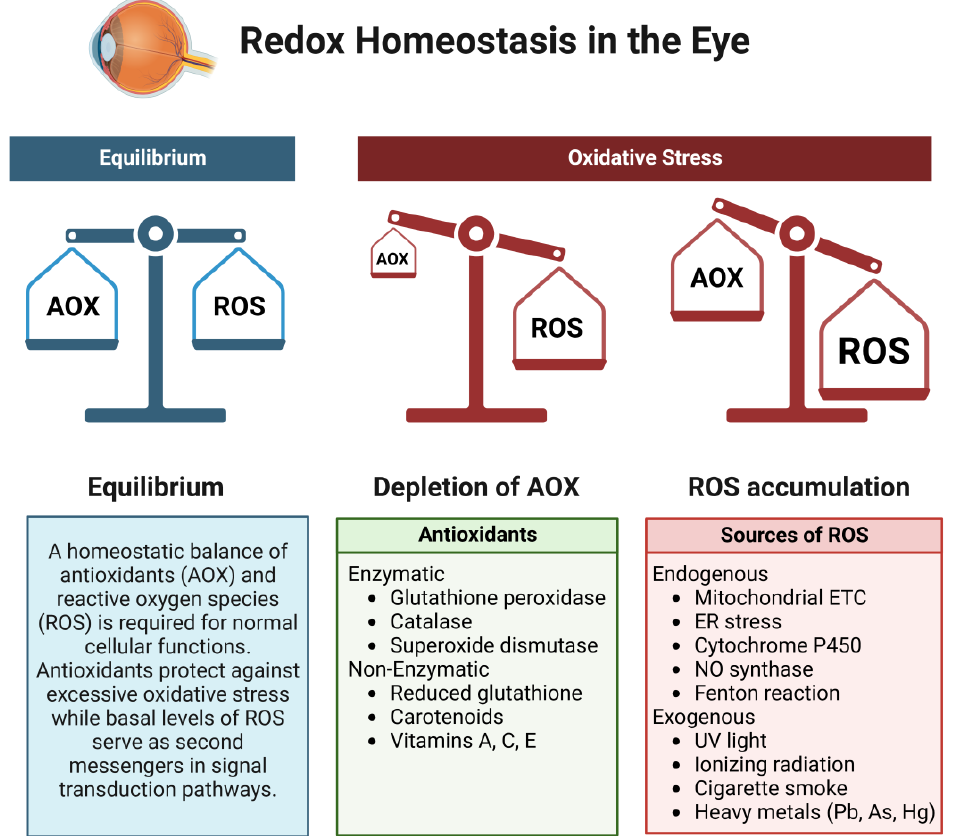
Figure 1. Redox homeostasis in the eye. A homeostatic balance of antioxidants and reactive oxygen species (ROS) is required for the healthy functioning of ocular tissues. An imbalance of antioxidants (AOX) and ROS through either the depletion of antioxidants or excessive ROS accumulation will result in oxidative stress and drive subsequent disease progression. Antioxidants are categorized as either enzymatic or non-enzymatic. ROS can be derived from either endogenous or exogenous sources. Examples of heavy metals include lead (Pb), arsenic (As), and mercury